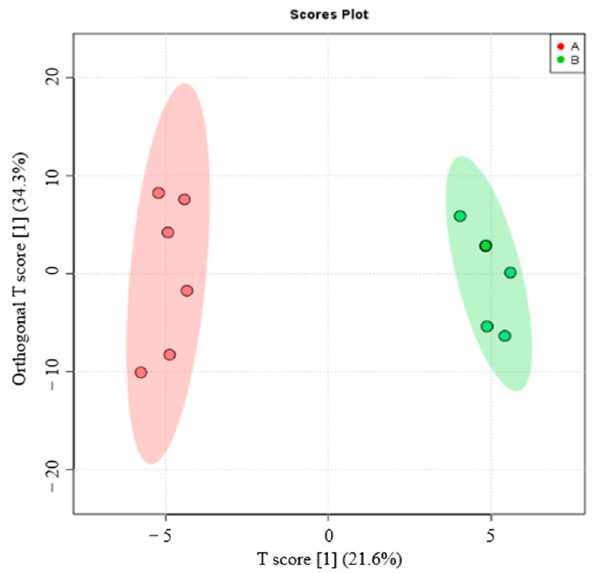
Figure 9. Orthogonal partial least squares discriminant analysis (OPLS–DA) score diagram shows the screening of different litter metabolites of plantation ( A ) and original forest ( B ).